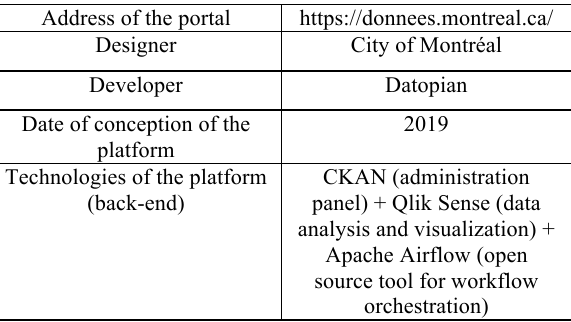
Table 1: Technical characteristics of the Montreal